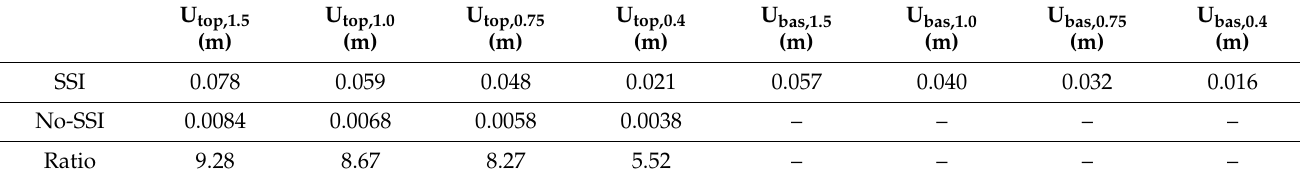
Table 4. Results obtained by the two models, considering and neglecting SSI, in terms of horizontal displacements at: the top (U top,k ) and base (U bas,k ) of the pier, for the k seismic inputs. U top,1.5 (m)